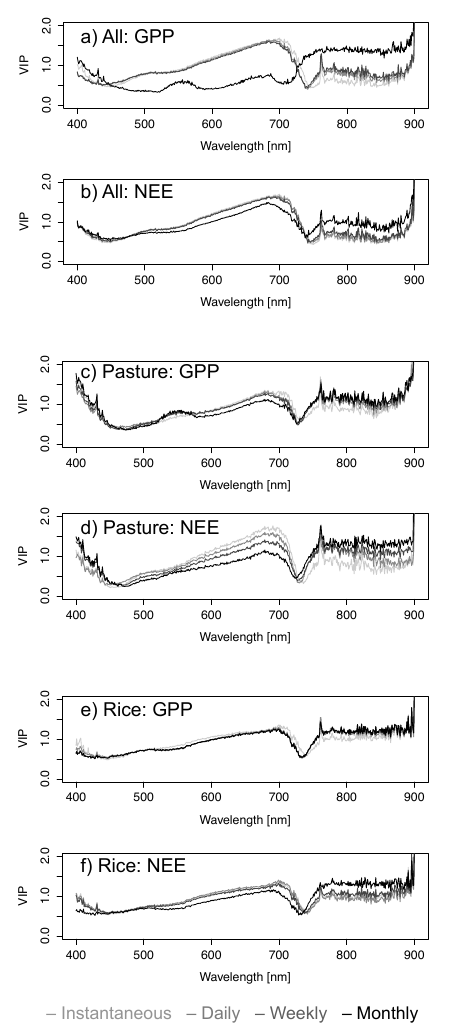
Figure 5. Variable importance of projection (VIP) statistics for bootstrapped partial least-squared regression (PLSR) modeling co- efficients. Here we show the variable importance of projection (VIP) statistics for the mean bootstrapped PLSR models, fitted to the GPP and NEE flux data sets. The VIP statistic describes the rel- ative contribution of each wavelength to the predictive power of the PLSR model across all final PLSR model components. Across all models, the visible wavelengths (400–700nm) were most impor- tant for prediction at shorter timescales of integrated flux, while the infrared wavelengths (700–900nm) became increasingly important at longer integrated flux intervals. This pattern is particularly appar- ent within the PLSR model for GPP fitted across all data (a) , where there was a dramatic shift in the VIP statistics between the weekly and monthly integrated flux prediction and the infrared wavelengths become much more important for prediction at longer timescales. This pattern was also apparent with the PLSR models developed using the Pasture data only. The PLSR models developed for the Rice data only (e–f) had the least variation for fluxes integrated at different timescales.